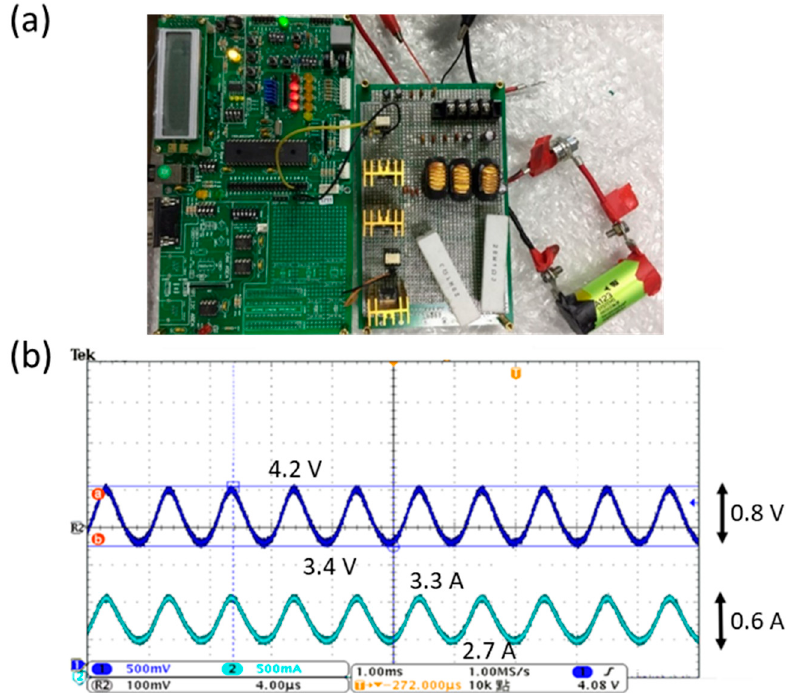
Figure 6. ( a ) Photo of the actual circuit; ( b ) Waveform of the output voltage.